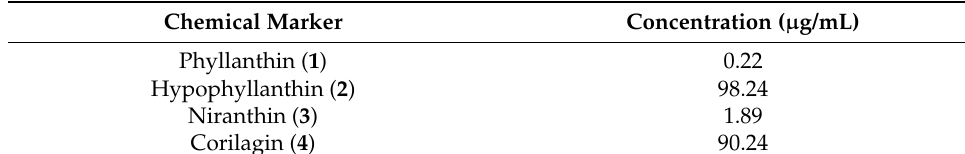
Table 4. Quantification of P. amarus compounds in the crude extract.